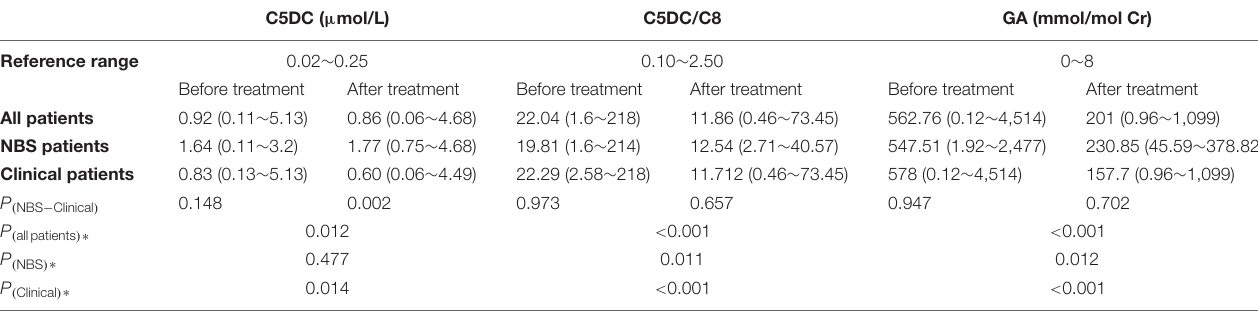
TABLE 2 | Levels of C5DC in the blood, C5DC/C8 ratios and urinary GA in each of the three